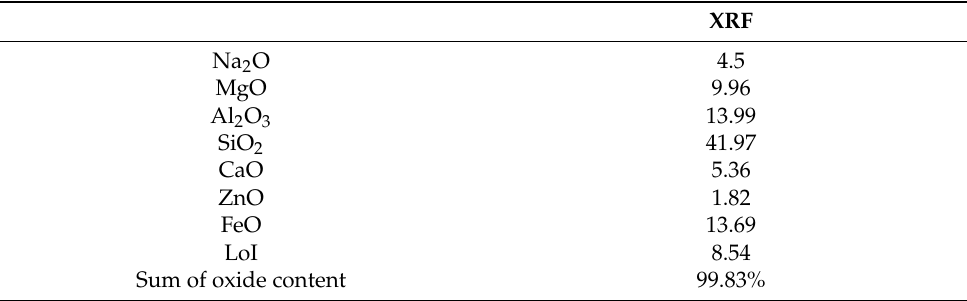
Table 1. Chemical analysis of diabase mud.